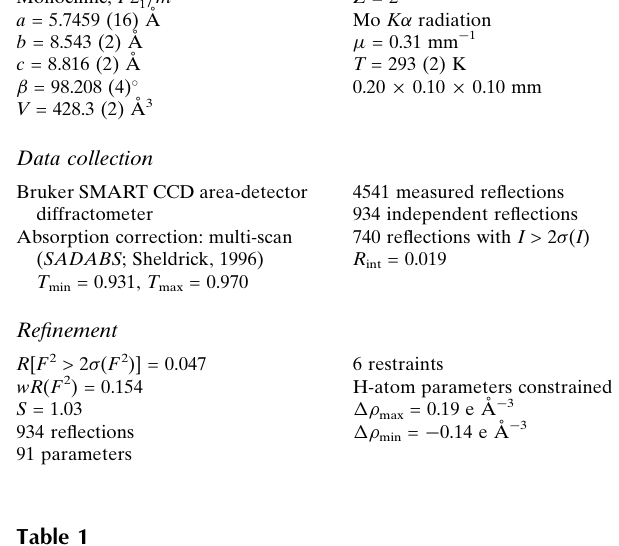
Hydrogen-bond geometry (A˚ , (cid:2)